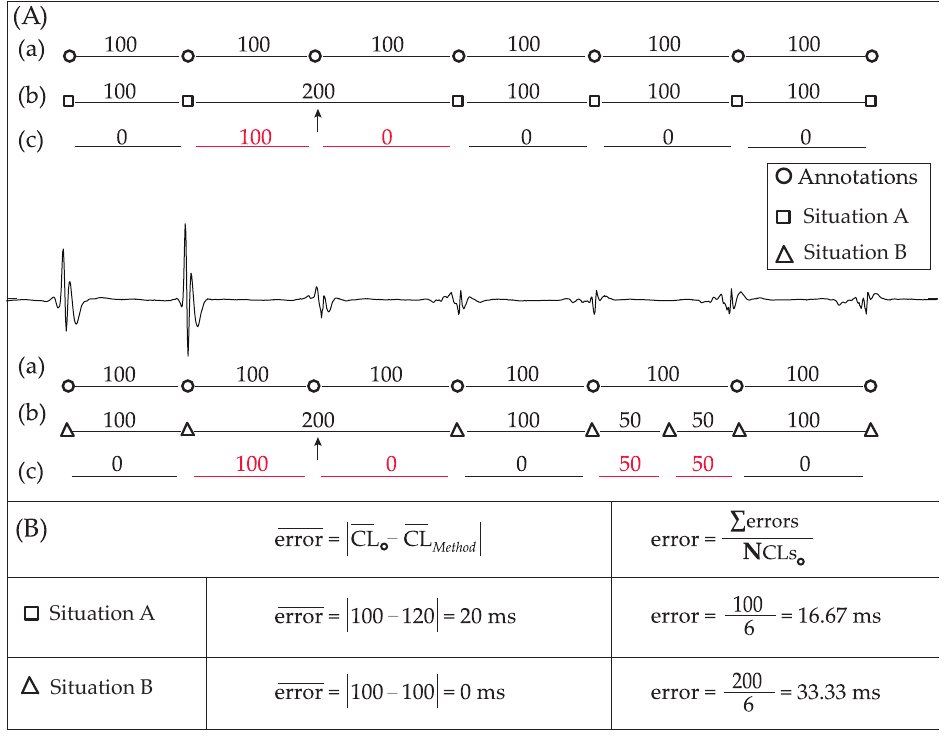
Figure 3. Comparative example for calculating the CL estimation error. ( A ) EGM with experts’ (circle) and method’s annotations: (a) expert’s CL (b) method’s CL and (c) errors in CL estimation. Top: Situation 1 (squares) undersensing case (missing activation-red). The arrow shows the starting points in case of unequal CLs for the undersensing case; Bottom: Situation 2 (triangles) undersensing and oversensing case (false positive activation-red). ( B ) Error estimation for the two example situations. (left) Mean CL error; (right) Individual CL error. Notice how the simultaneous existence of under- and oversensing in Situation 2 may create erroneous CL calculation for the mean CL